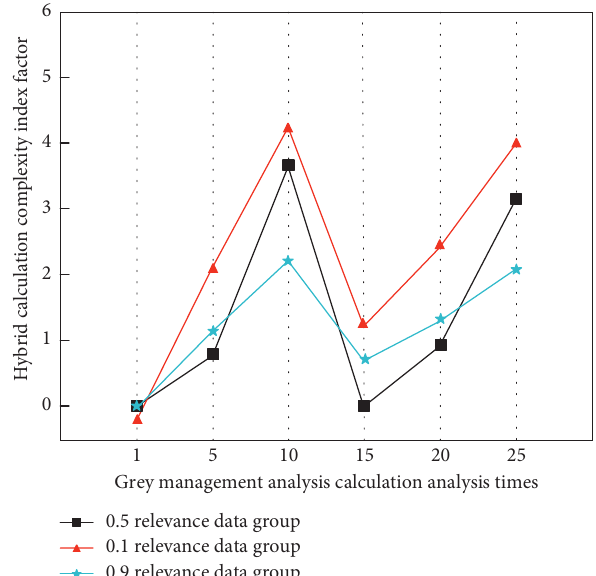
Figure 3: Simulation analysis results of 3 sets of known data with different correlation